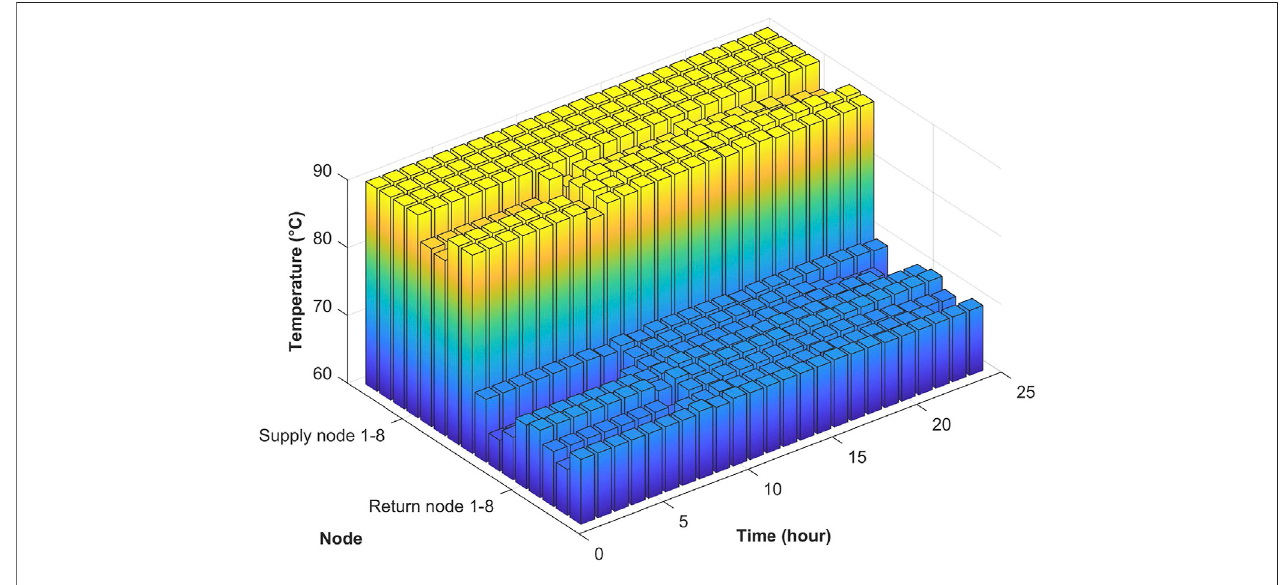
FIGURE 9 | Temperatures for each node in the heat network.